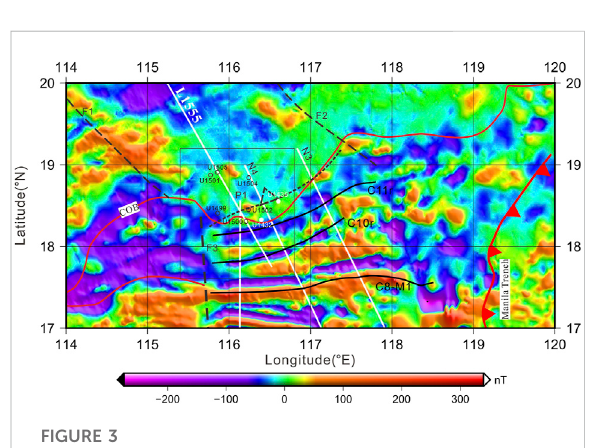
FIGURE 3 RTP magnetic anomalies in the northern